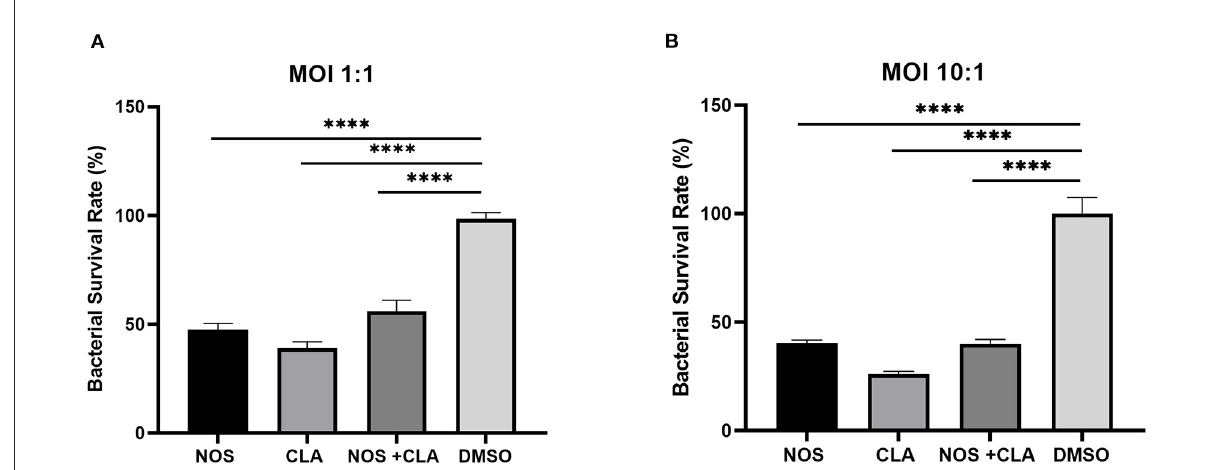
FIGURE7 The intracellular bacterial survival rate of M. abscessus ATCC 19977 with NOS exposure. (A) At an MOI of 1:1. (B) at an MOI of 10:1. NOS group: infected macrophage treated with NOS (2 µ g/ml); CLA group: the positive control, infected macrophage treated with CLA (2 µ g/ml); NOS + CLA group: infected macrophage treated with NOS (1 µ g/ml) and CLA (1 µ g/ml); DMSO group: the negative control. All data are shown as the means ± SD ( n = 3). **** P <